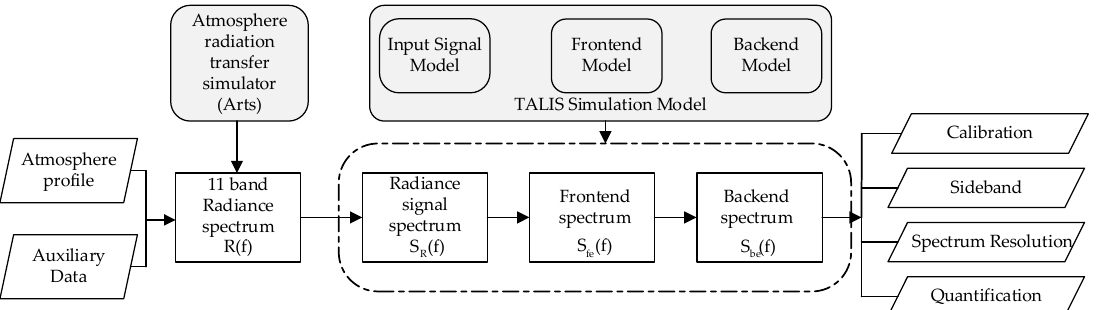
Figure 3. Simulation flow chart for performance evaluation of TALIS.